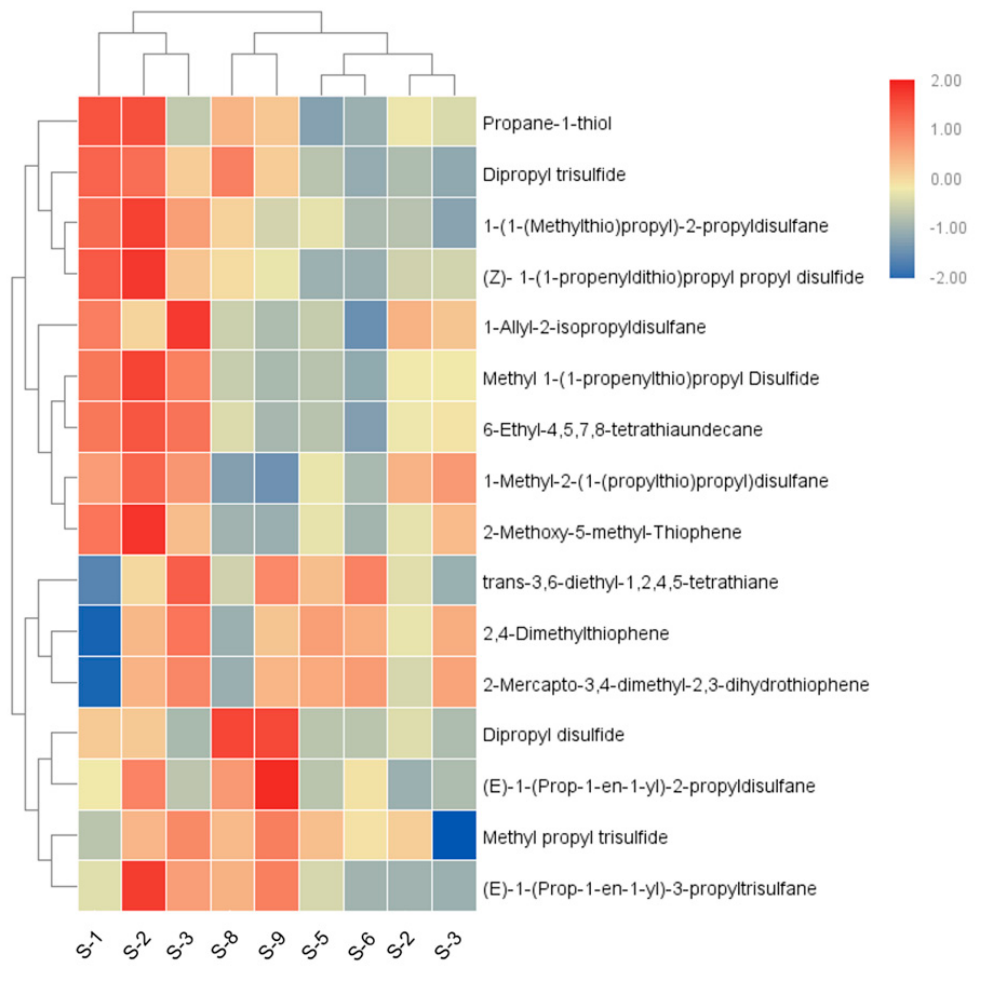
Figure 3. Clustering heat map of volatile sulfur compounds in each sample. “S − 1”, “S − 2”, and “S − 3” represent the onion bulbs, onion rings, and onion squares stored at 4 °C; “S − 4”, “S − 5”, and “S − 6” represent the onion bulbs, onion rings, and onion squares stored at 20 °C; “S − 7”, “S − 8”, and “S − 9” represent the onion bulbs onion rings, and onion squares stored at 25 °C.